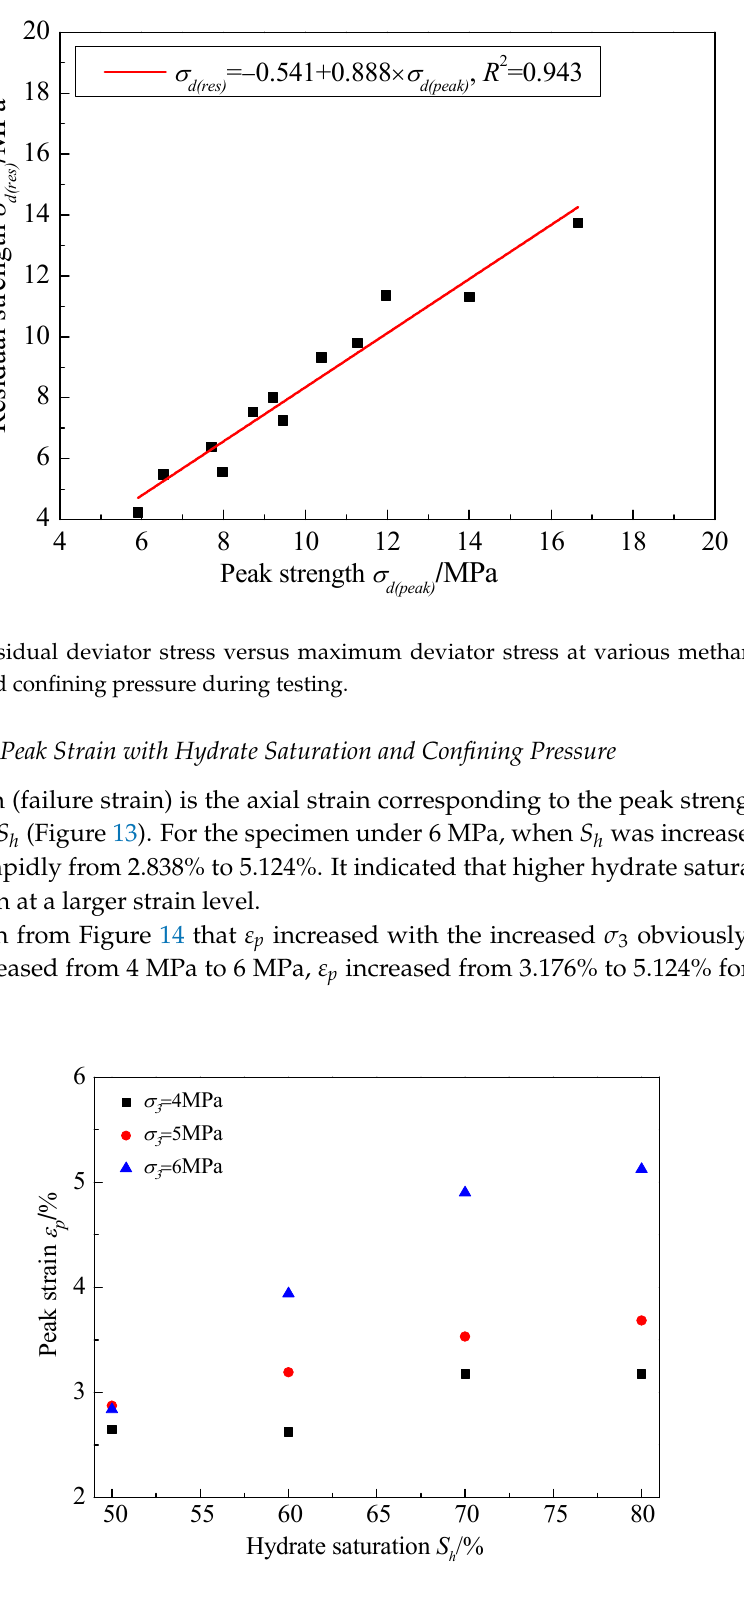
Figure 11. Variation of the residual strength with the confining pressure.